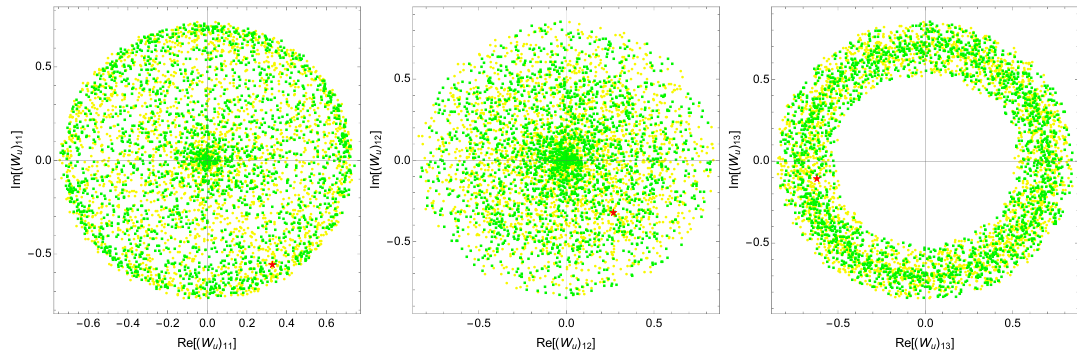
Figure 3 . Each element in ( W u ) 1 i which can explain ( g − 2) µ and KOTO anomalies within 1 σ (green square) and 2 σ (yellow circle). In these plot, we set m Z 0 = 140 MeV. The red star denotes the benchmark point for figure